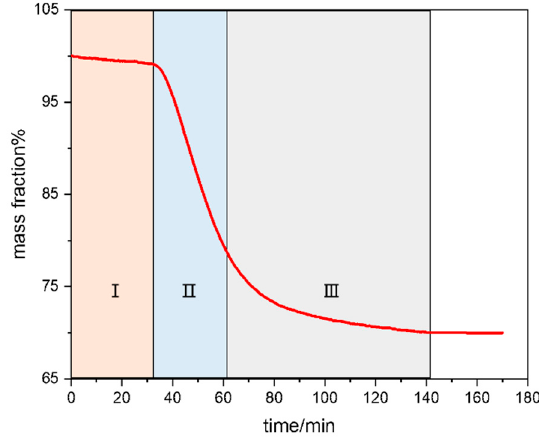
Figure 5. The three stages of low-temperature decomposition for AP.